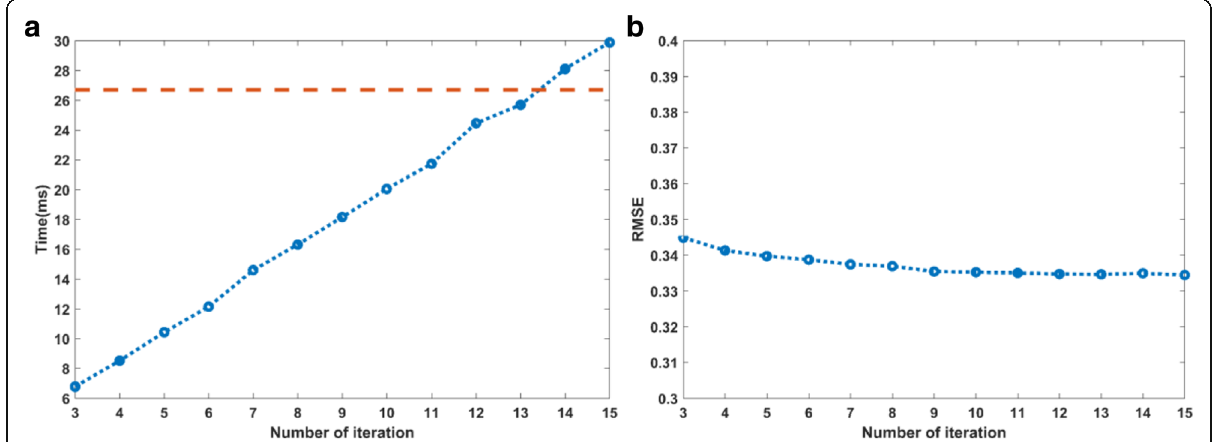
Fig. 6 Performances of different iterations: time and RMSE performances of different numbers of iterations. a Time performance. b RMSE